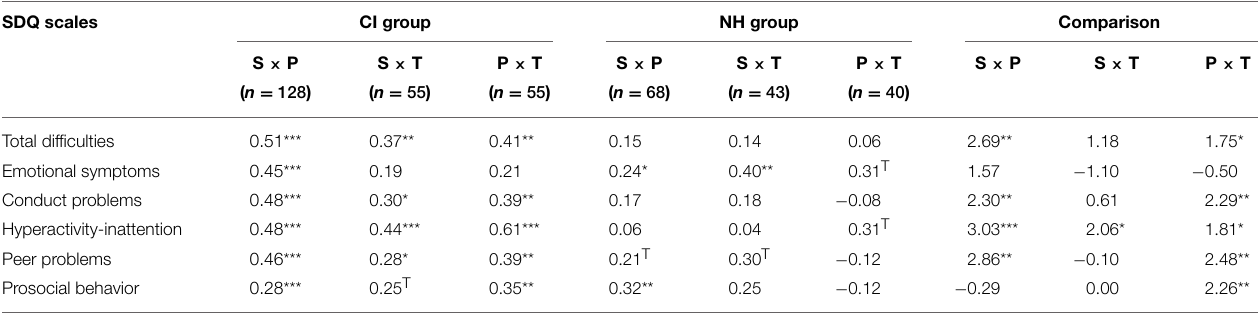
TABLE 4 | Inter-rater agreement between self, parent and teacher ratings in CI group and NH group: Correlation between SDQ scales from different informants. SDQ scales CI group NH group